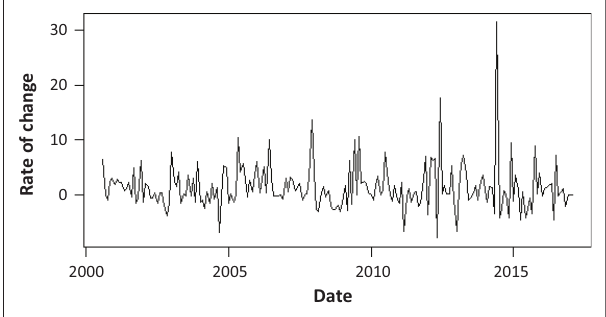
FIGURE 12: Kenya – Movement of the rate of change of monthly exchange rate.